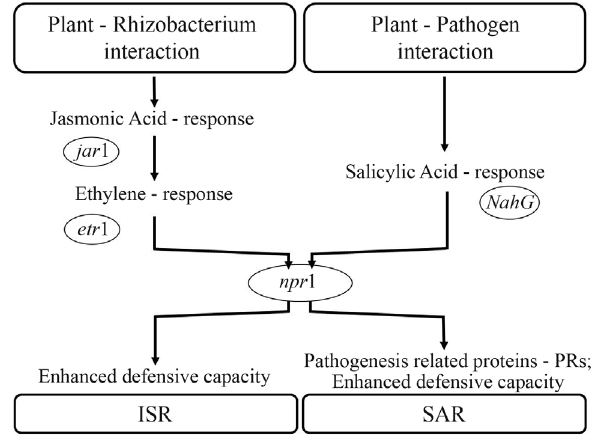
Figure 1 - Signal transduction pathways leading to pathogen-induced sys- temic acquired resistance (SAR) and rhizobacteria-mediated induced sys- temic resistance (ISR) in Arabidopsis thaliana . Modified from : Van Loon et al. ,